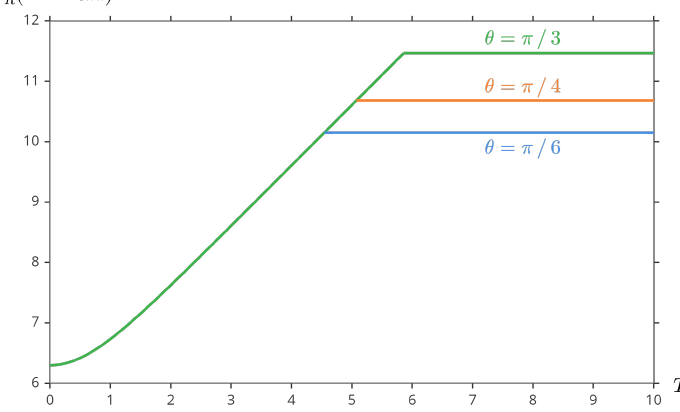
Figure 18. The reflected entropy between black hole and radiation (in the unit of c to time T for X 0 = 1 and θ = π